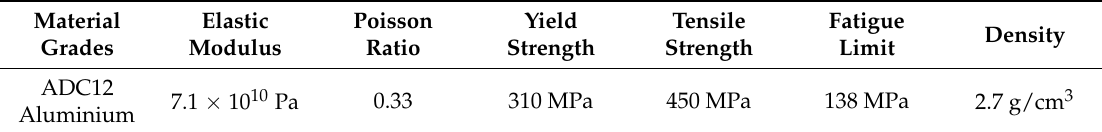
Table 2. Material